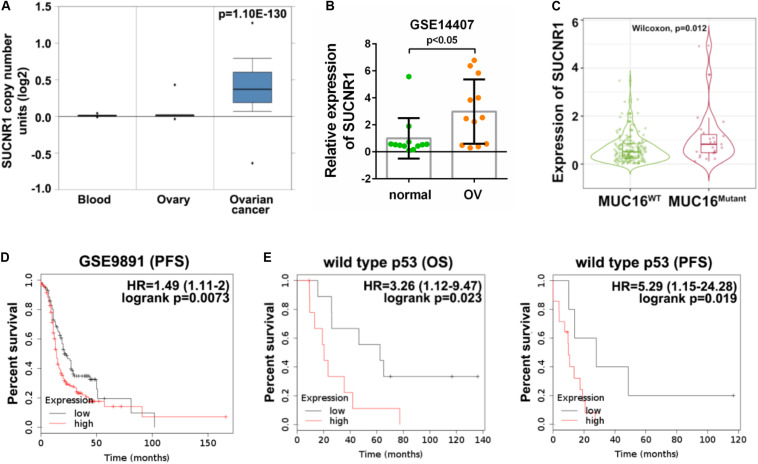
The genetic profile and prognostic value of SUCNR1 in ovarian cancer. (A) Copy number of SUCNR1 in normal blood, ovary, and ovarian cancer are available on the Oncomine database. (B) The expression of SUCNR1 between ovarian surface epithelial cells and serous ovarian cancer available at GSE14407, ∗p < 0.05. (C) The expression of SUCNR1 between MUC16 wild-type samples and MUC16 mutant samples of ovarian cancer are available on the TIMER2.0 database, ∗p < 0.05. (D) Kaplan-Meier PFS (progression-free survival) curves in SUCNR1 high and low expression ovarian cancer patients from GSE9891. (E) Kaplan-Meier OS (overall survival) and PFS curves in SUCNR1 high and low expression ovarian cancer patients with wild-type p53 from GSE9891.